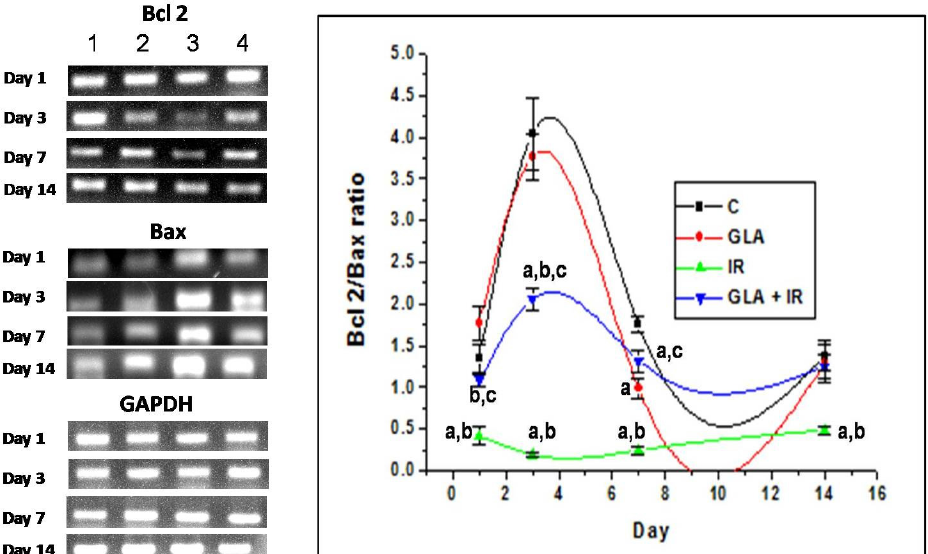
Figure 15. Effect of GLA and irradiation on genes associated with apoptotic pathways (BCL-2 and Bax) in duodenum tissue on day 1, day 3, day 7, and day 14. Values (n = 3) expressed as mean ± SEM. a , b , c Significant ( p < 0.01) when compared with control, GLA, and IR, respectively. 1, C; 2, GLA; 3, IR; and 4, GLA + IR. C, control; GLA, gamma-linolenic acid; IR, irradiation (7.5 Gy).